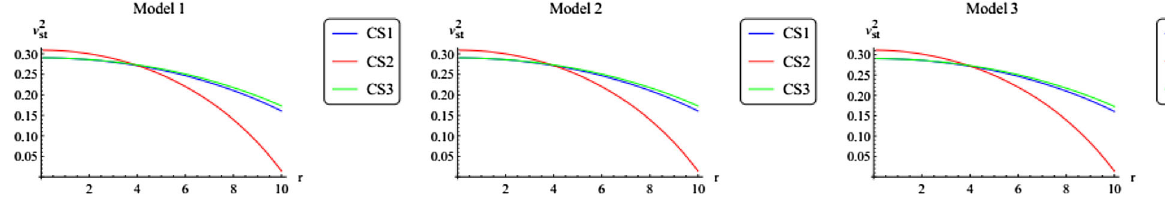
Fig. 11 Variations of v 2 st for different viable f ( G ) gravity models